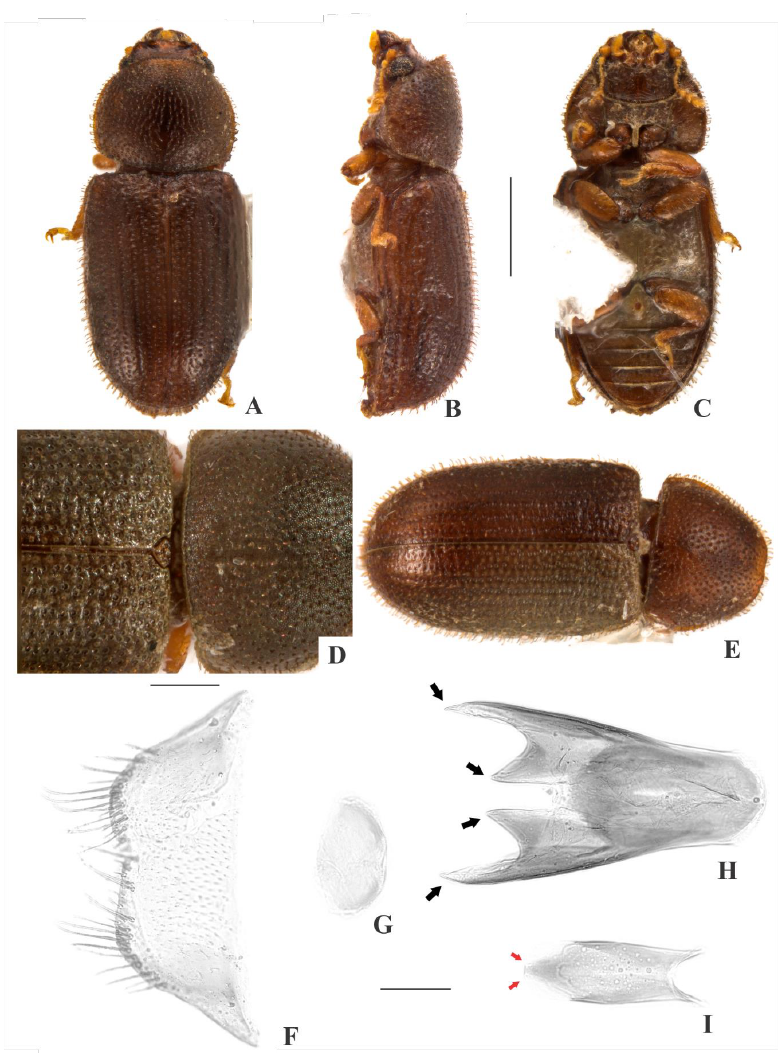
Figure 4. Cis grobbelaarae sp. n. , male holotype ( A – D ), female paratype ( E ), aedeagus of paratype from type locality ( F – I ): A. Dorsal view. B. Lateral view. C. Ventral view. D. Scutellar shield and part of the pronotum and elytra. F. Sternite VIII. G. Basal piece. H. Tegmen, note angulations at apical corners (black arrows). I. Penis, note truncate apex (red arrows). Scale bars: 0.5 mm ( A – C , E ), 0.2 mm ( D ), 0.05 mm ( F – I ).